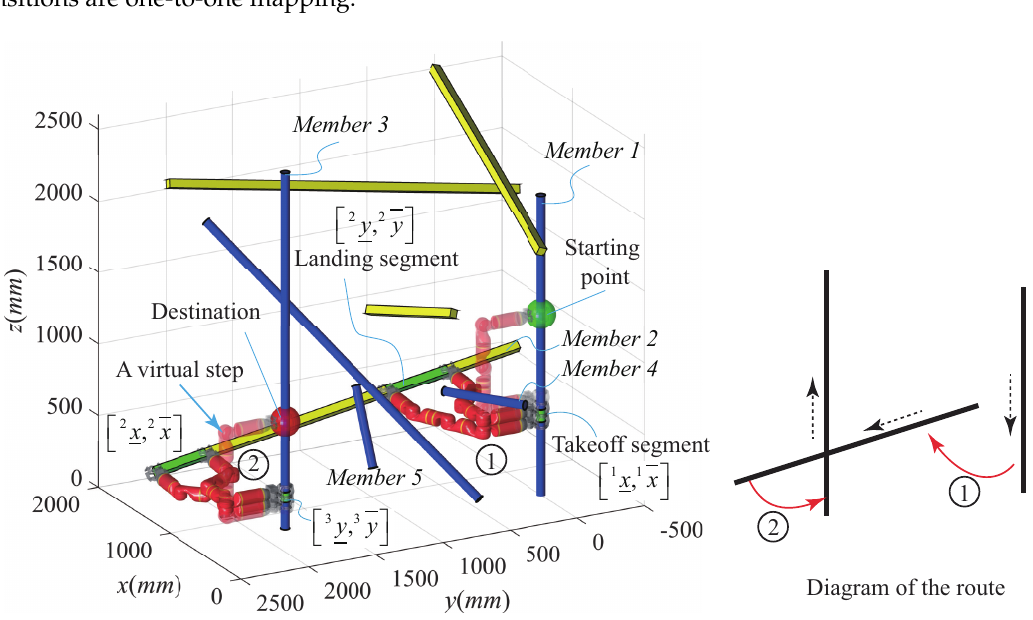
Figure 2. An illustration of a feasible route. Green and red spheres in the figure stand for the initial position and the destination, respectively. Nearby numbers indicate the sequence of transitions to be performed along the